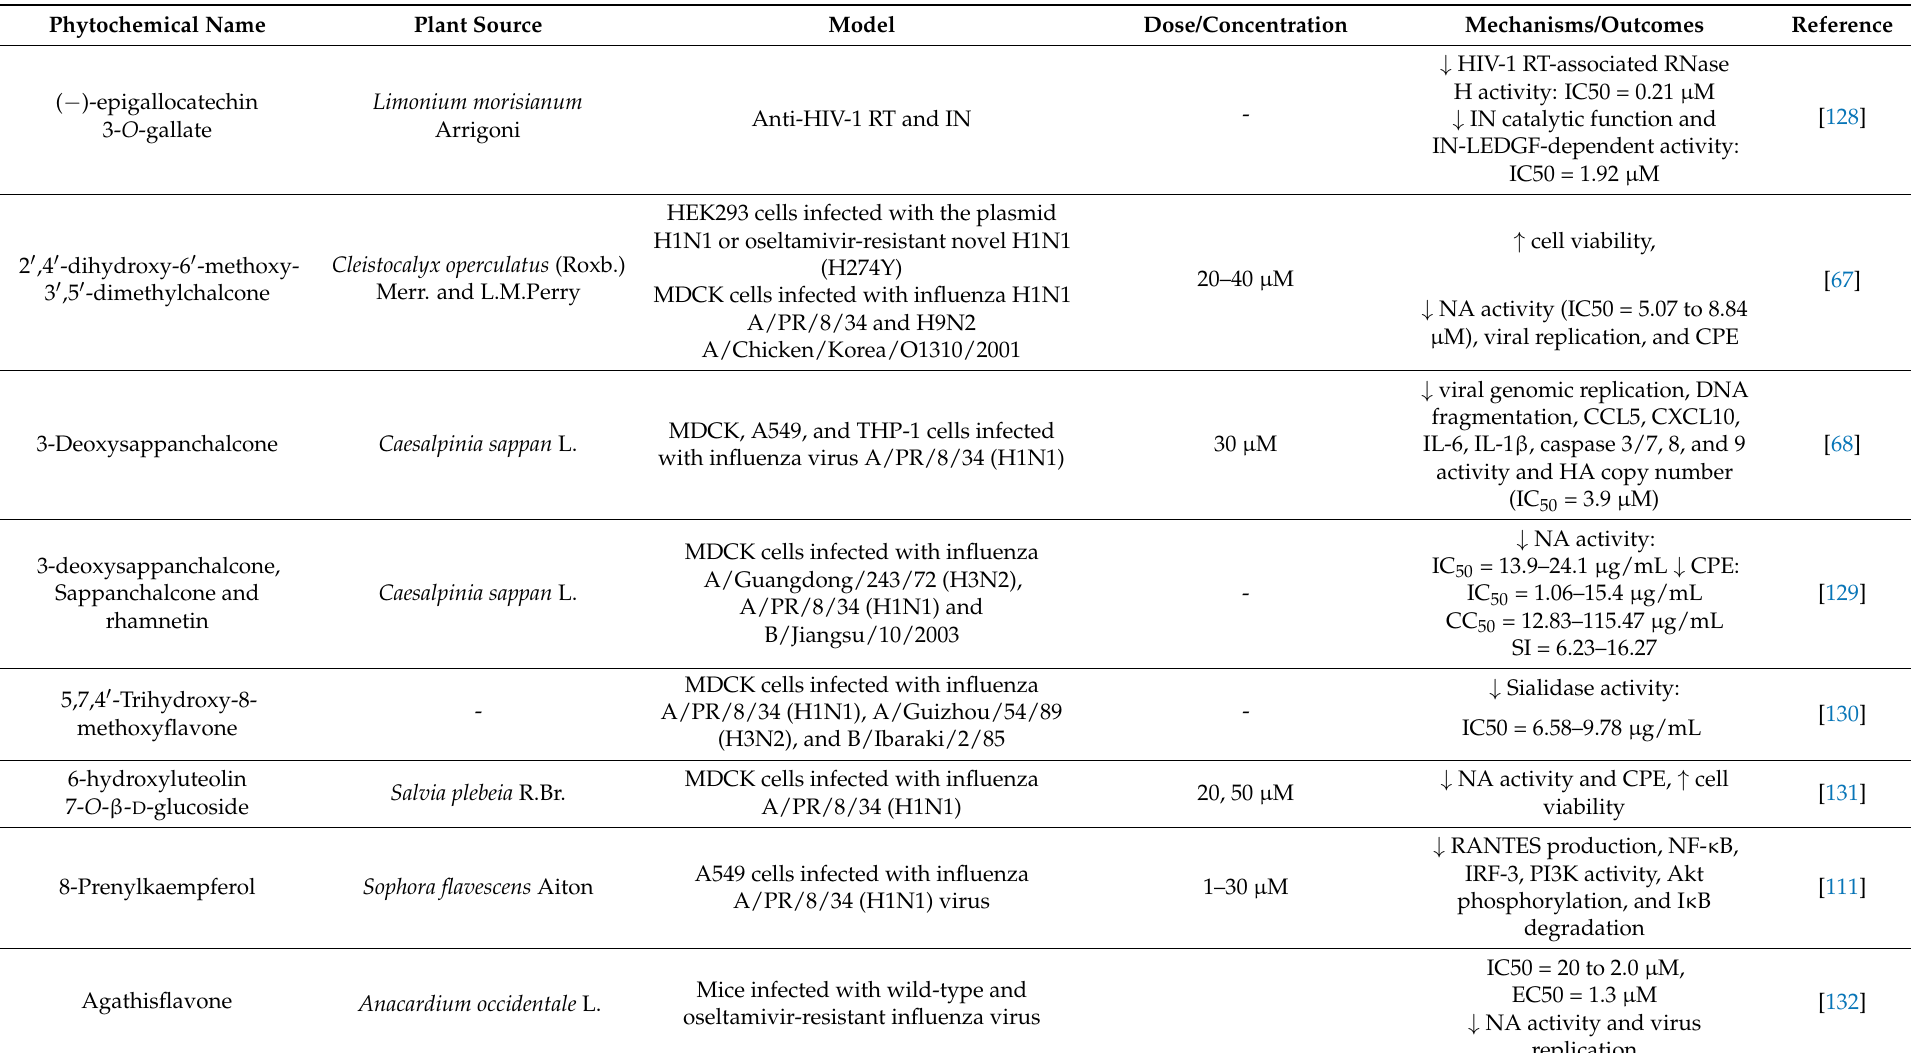
Table 1. Flavonoids with antiviral properties against SARS-CoV-2 and viral infections with similar